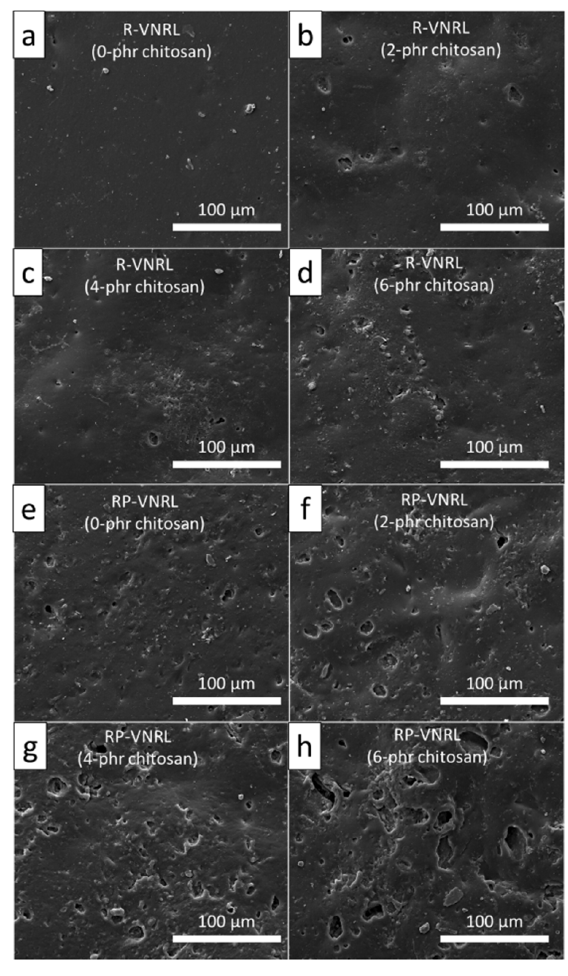
Figure 8. SEM images showing morphologies of ( a ) R-VNRL, ( b ) 2-phr CS/R-VNRL, ( c ) 4-phr CS/R- VNRL, ( d ) 8-phr CS/R-VNRL, ( e ) RP-VNRL, ( f ) 2-phr CS/RP-VNRL, ( g ) 4-phr CS/RP-VNRL, and ( h ) 6-phr CS/R-VNRL composites after the soil burial for 8 weeks.